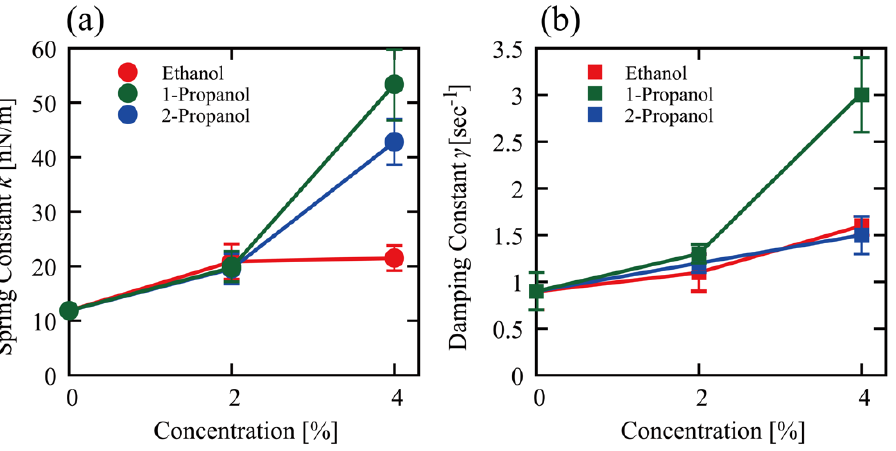
Figure 5. Viscoelasticity of single T4 GT7 DNA molecules (166 kbp) at different concentrations of ethanol, 1-propanol, and 2-propanol, as evaluated from the autocorrelation function shown in Figure 4. ( a ) Spring constant k and ( b ) damping constant γ . Data presented as mean ± SEM.